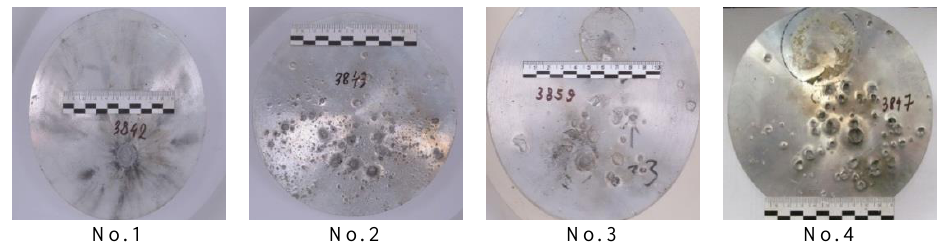
Fig 8. Craters in the barrier-“witness” after drummer’s impact on the sample in the second series of